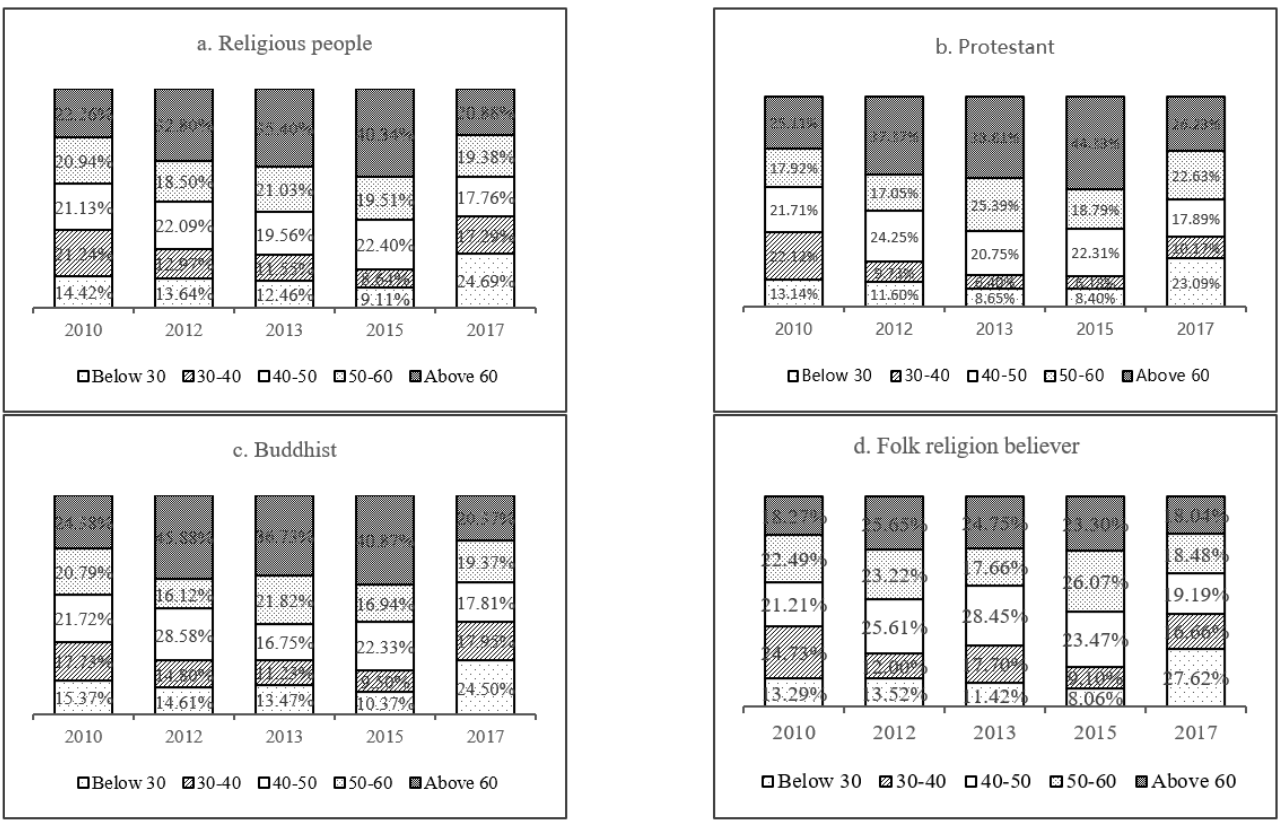
Figure 2. Tendencies in the age composition.